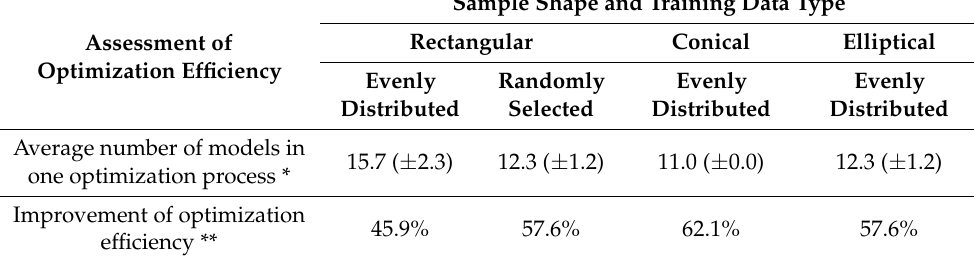
Table 3. Optimization